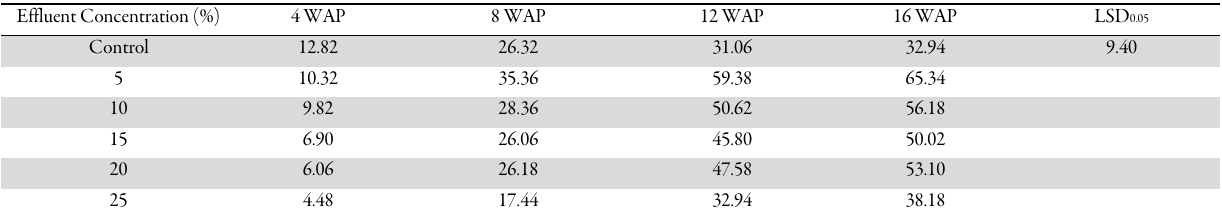
Table 1. Plant height (cm) of Solanum lycopersicum treated with different concentrations of detergent effluent Effluent Concentration (%)